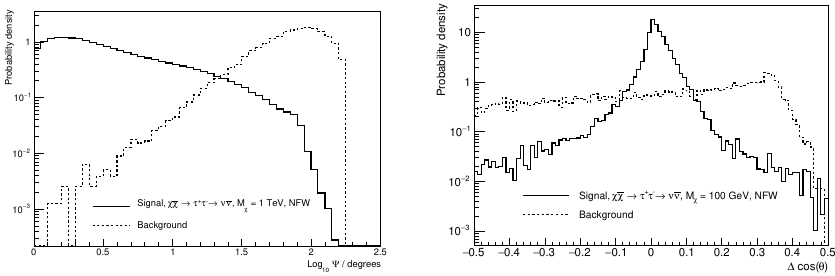
Figure 1. PDFs for ANTARES, multi-line (left) and single-line (right) events. For multi-line events the discriminating variable is the angular o ff set Ψ between each neutrino track and the Galactic Centre. For single-line events, the discriminating variable is the zenith cosine di ff erence between each event and the Galactic Centre. The signal is represented here for τ + τ − annihilation channel, NFW profile, M χ = 1 TeV / c 2 (multi-line) and M χ = 100 GeV / c 2 (single-line),